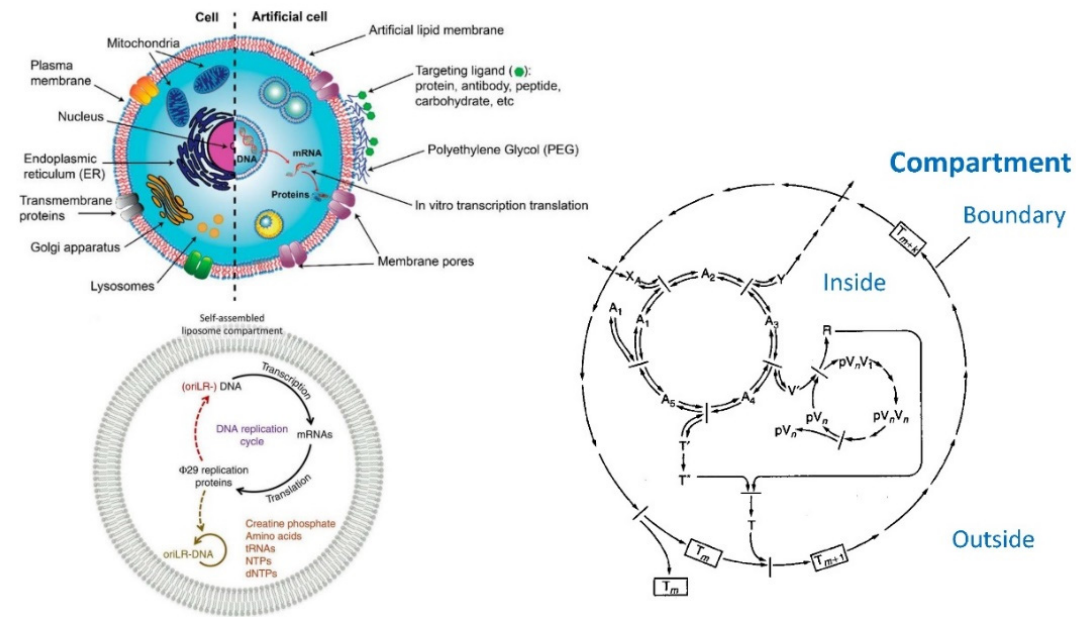
Figure 41. Attempts to prepare vesicle-based cell-like compartment systems “bottom-up”. Left, top : Conceptual comparison of a biological cell and a cell-like vesicle system for possible in vivo applications, as published by Trantidou et al. (2017) [550]. The membrane of the cell-like vesicle system is engineered by specific functionalization on the surface (PEGylation and targeting units; see Figures 16b and 22. The insertion of protein pores act as gateways, and membrane-bound subcompartments inside the vesicle can segregate content and perform distinct functions, such as in vitro transcription and translation. Left, bottom : Schematic representation of intra-vesicular DNA self-replication and the transformation of the genetic information from DNA to mRNA, which results in the expression of proteins for which the DNA sequence codes (the genome of bacteriophage Φ 29), achieved with the cell-free protein expression system PURE (“protein synthesis using recombinant elements) system [562,563], as published by van Nies et al. (2018) [37]. Right : The “chemoton” minimal model for the chemical organization of a living system, as proposed and published by G á nti (1997) [560,561]. The “chemoton” model consists of two coupled intra-vesicular cycles, a metabolic cycle (left) and a genetic cycle (right), and a membranous boundary. Reproduced with permission from [550], American Chemical Society, 2017; from [37], Springer Nature, 2018; and from [558], Elsevier, 1997.